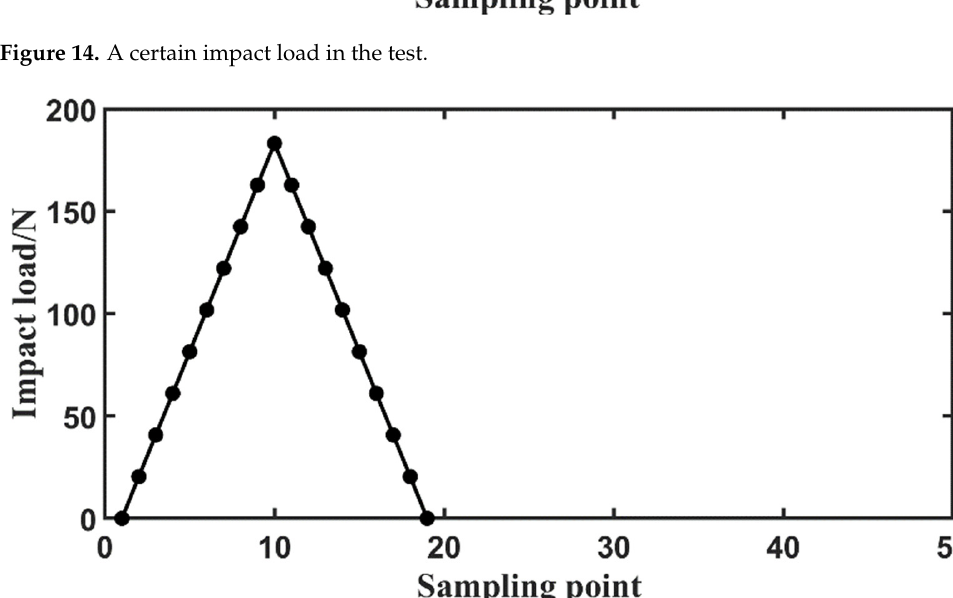
Figure 15. Standard load in symmetric triangular form.